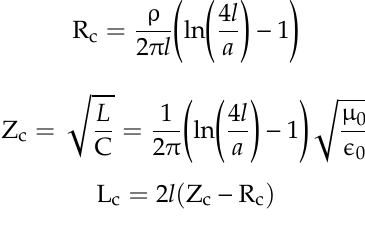
C L Figure 6. Conventional grounding system impedance model. Currently, in order to evaluate the high-frequency behavior of the grounding system, along with the effect of soil ionization, Figure 7 shows the circuit-based diagram of the proposed strategy. As is observed, there are some series impedance branches with their real or complex conjugate poles; those are enforced to be stable. It means that the real part of all fitted poles will have a negative value to be located at the left side of the imaginary axis in the complex plane. In (24), however, all the 𝑐 (cid:3041) and 𝑎 (cid:3041)